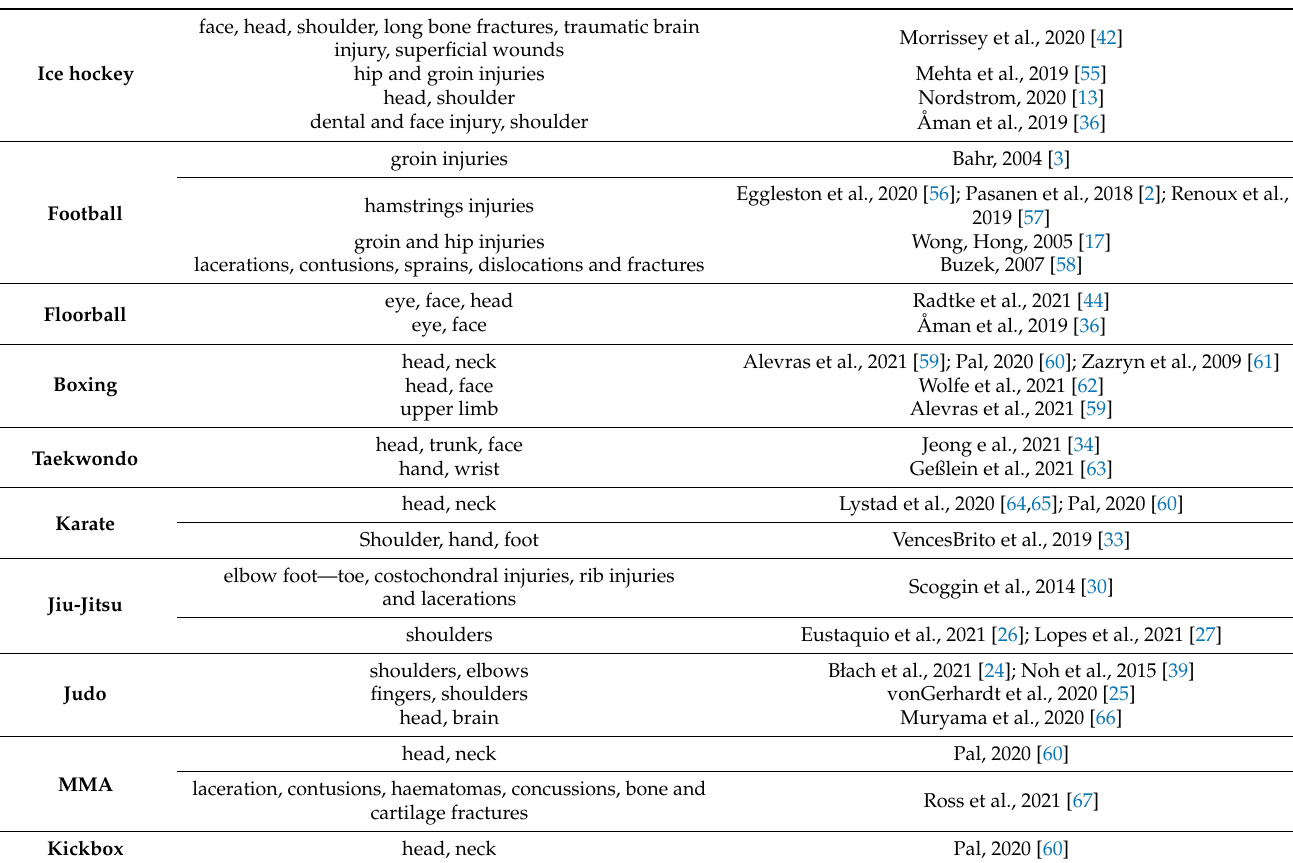
Table 2. Other sports